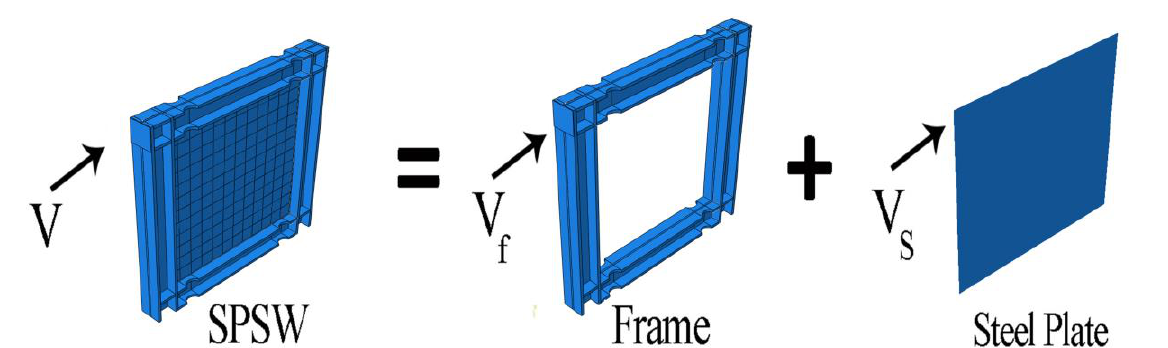
Fig. 7 . Components of SPSW (Wall-Frame